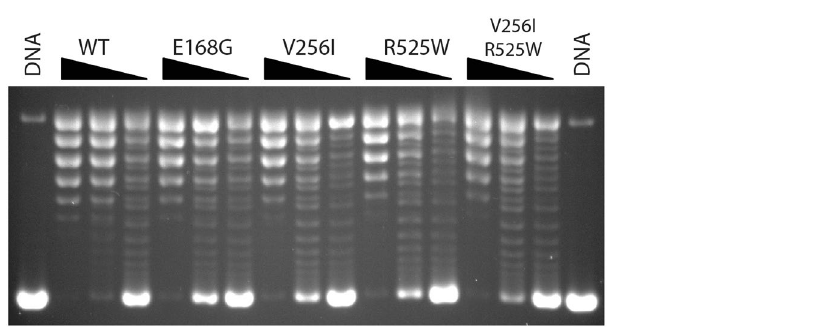
Figure 3. Relaxation activity of TOP1MT wild type and its variants assayed with negatively supercoiled pBR322 plasmid DNA. Equal concentrations (2 ng/ μ l) of each enzyme were used for a dilution series of 1:1, 1:3 and 1:9. A representative gel was